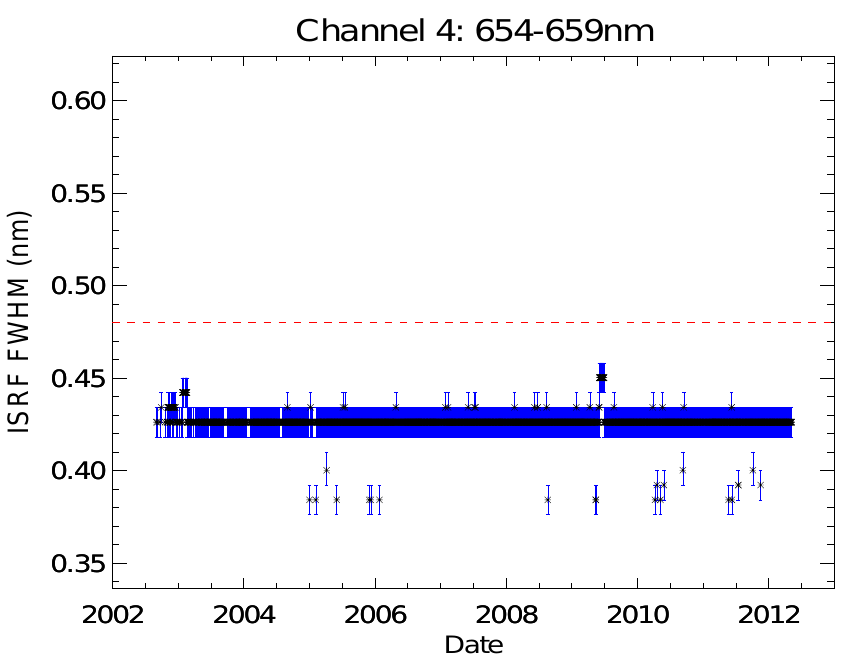
Figure 14. Similar to Figure 11 but for the solar line in Channel 4 (Table 4).